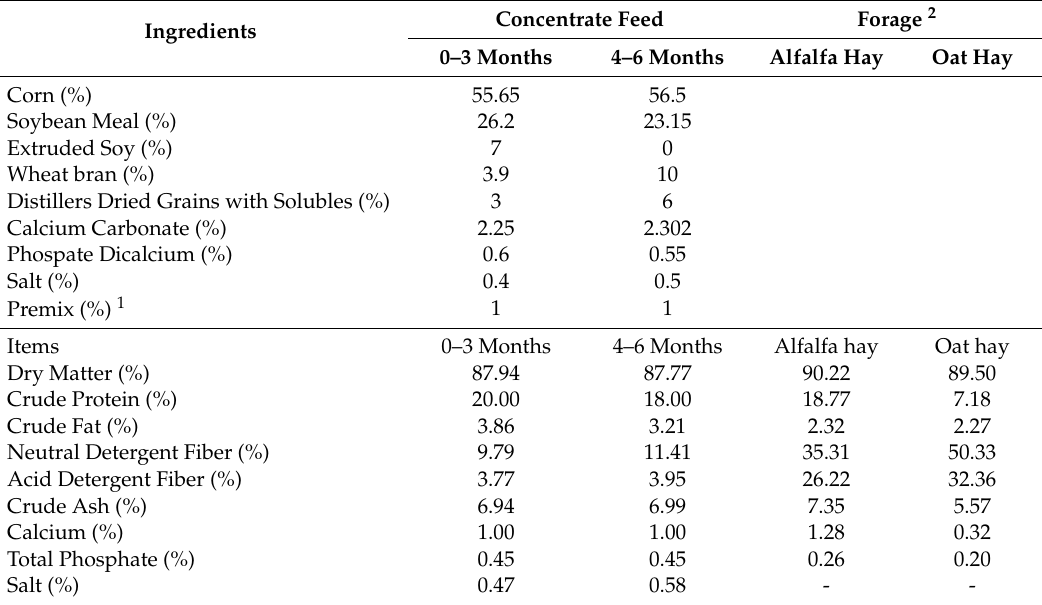
Table 3. Composition and chemical analysis of the concentrate feeds and forage (dry matter